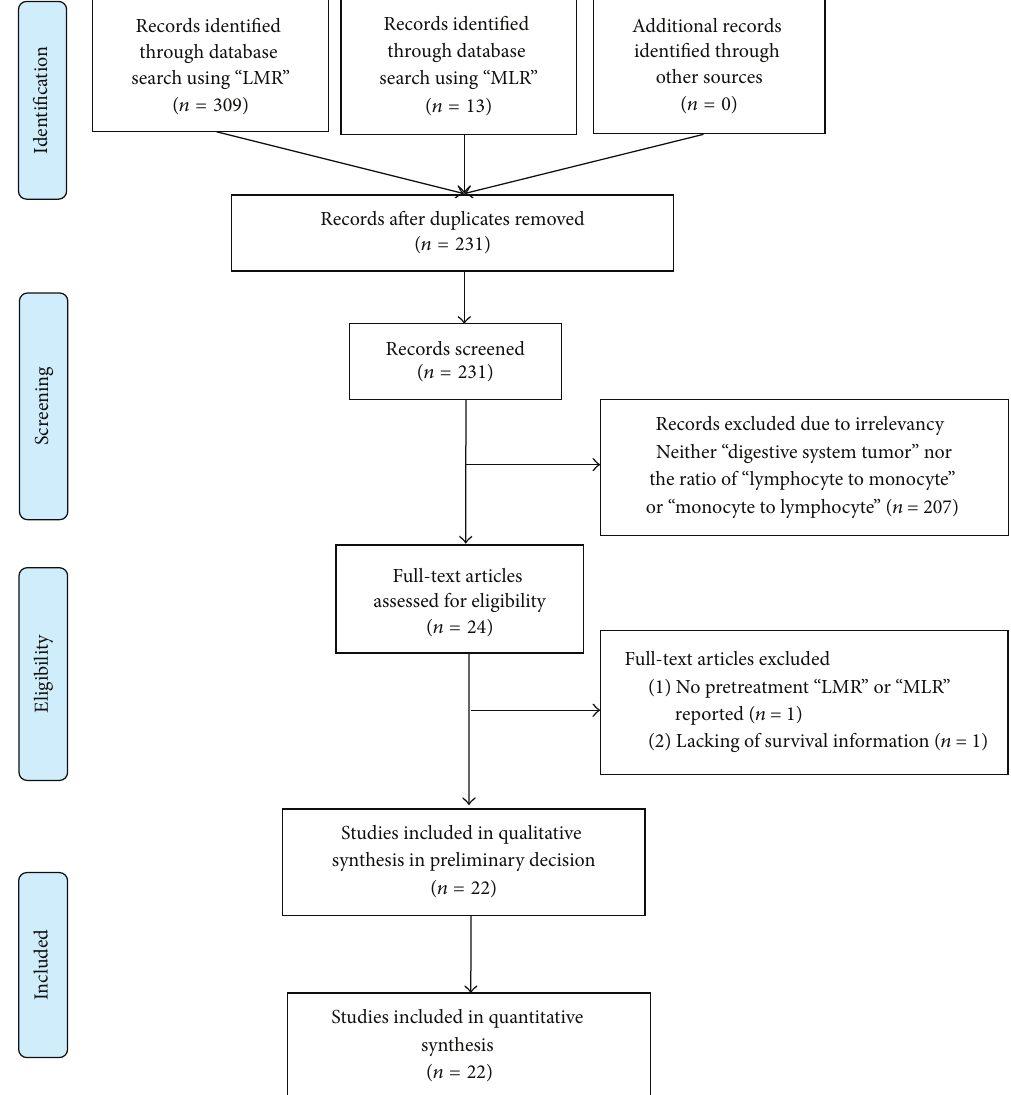
Figure 1: Selection of studies included in the analysis. LMR: lymphocyte to monocyte